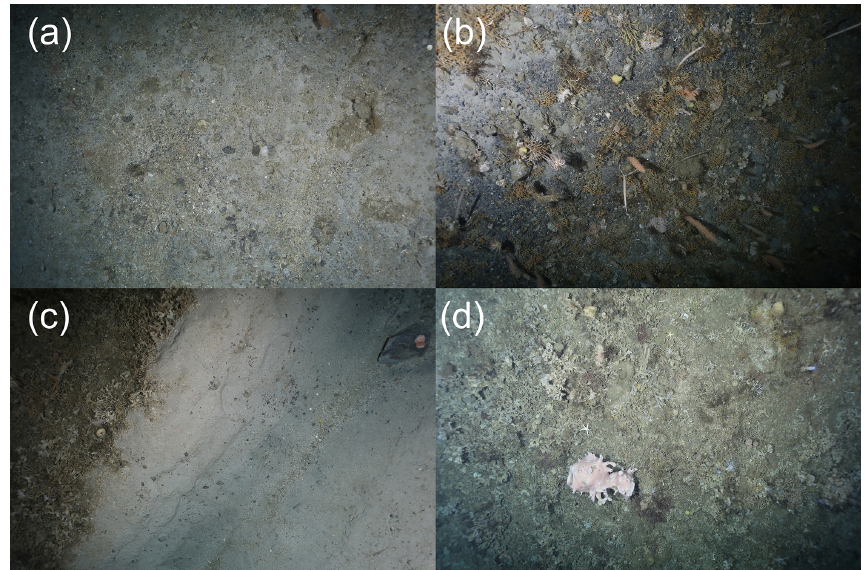
Figure 10. Typical seafloor images collected from each of the OFOBS surveys made of the coastal canyon seafloor dur- ing RV Polarstern cruise 124. All images were taken during deployment Station 90-13. (a) TIMER_2021_03_07 at 01_48_12 IMG_0078.JPG, (b) TIME_2021_03_07 at 02_48_47 IMG_0305.JPG, (c) SW_RELEASER_2021_03_07 at 03_31_08 IMG_0453.JPG, spacing). All images are presented here and in the dataset with no manipulation or colour